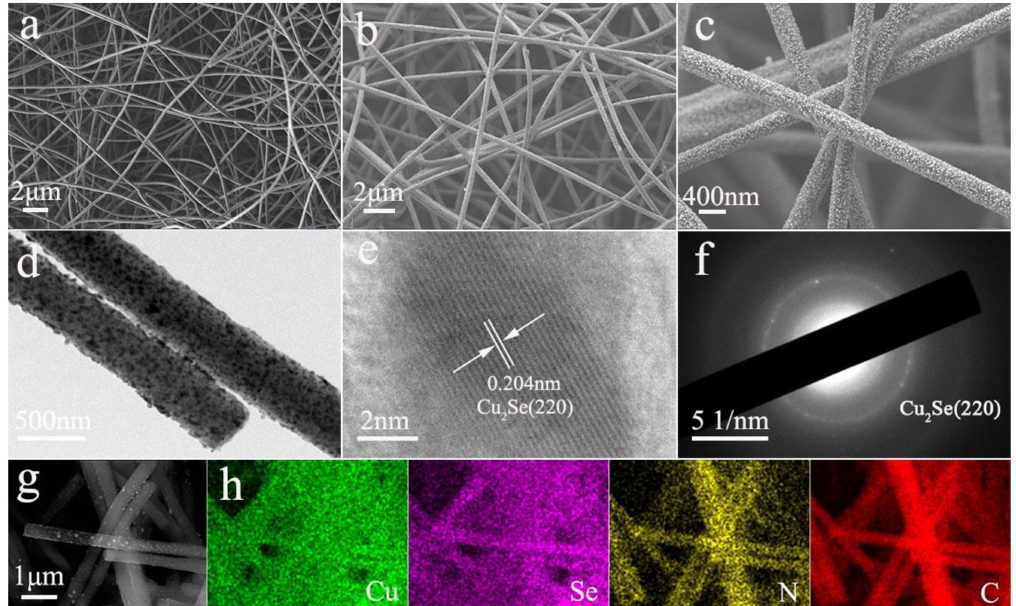
Figure 1. ( a ) SEM image of Cu(AC) 2 / PAN electrospun nanofibers; ( b , c ) SEM and ( d ) TEM images of Cu 2 Se-NC nanofibers after selenization treatment; ( e ) HRTEM image of Cu 2 Se-NC nanofibers. ( f ) Selected-area electron diffraction patterns of Cu 2 Se-NC nanofibers. ( g ) SEM image and ( h ) corresponding elemental mappings of Cu, Se, N, and C of Cu 2